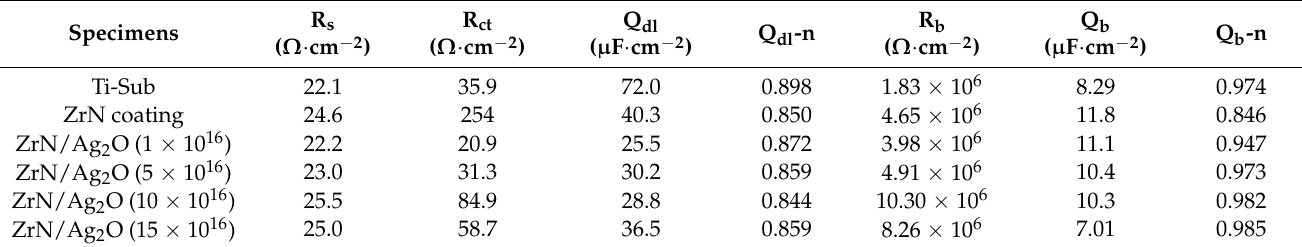
Table 2. Electrochemical parameters derived from impedance fitting for different specimens in Ringer’s solution.